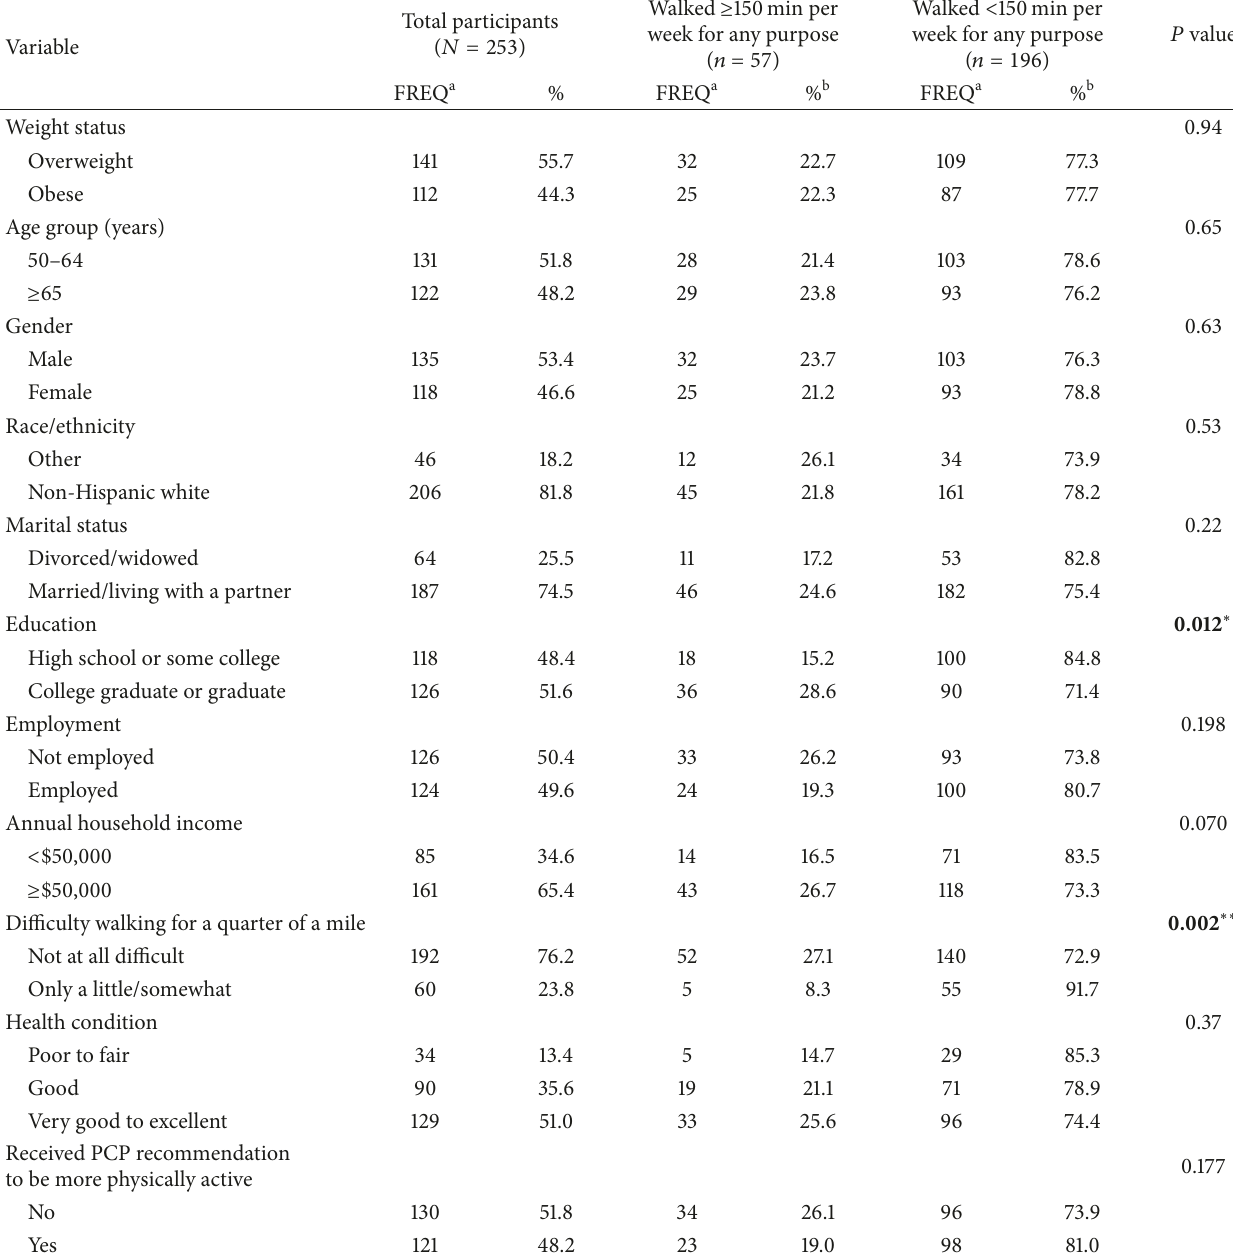
Table 1: Anthropometric, demographic, and health characteristics of study